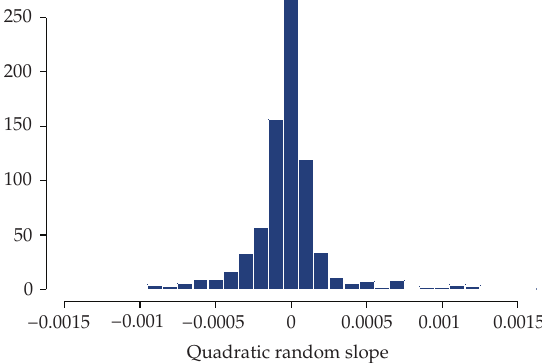
Figure 10: Histogram of quadratic random slope